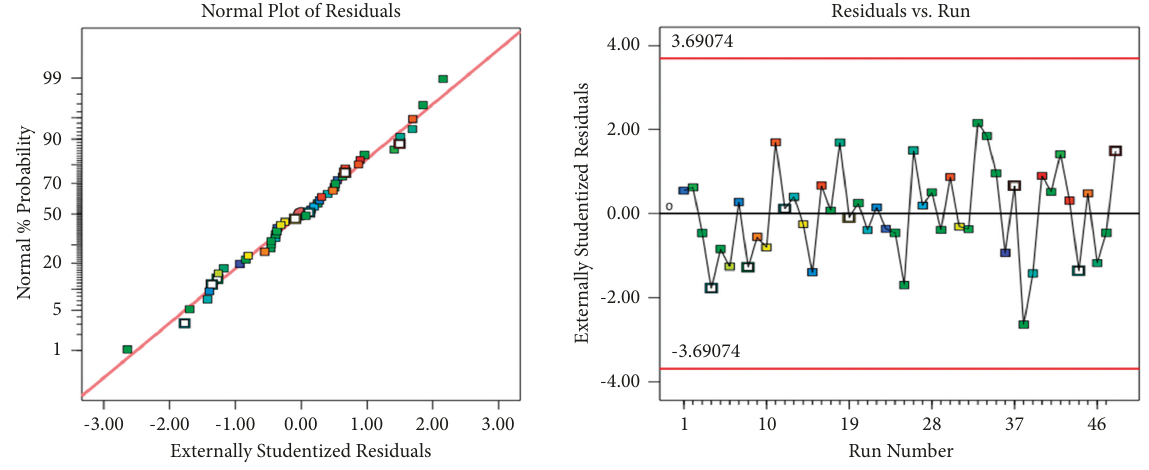
Figure 8: Distribution of normal probability percentage and residuals for COD